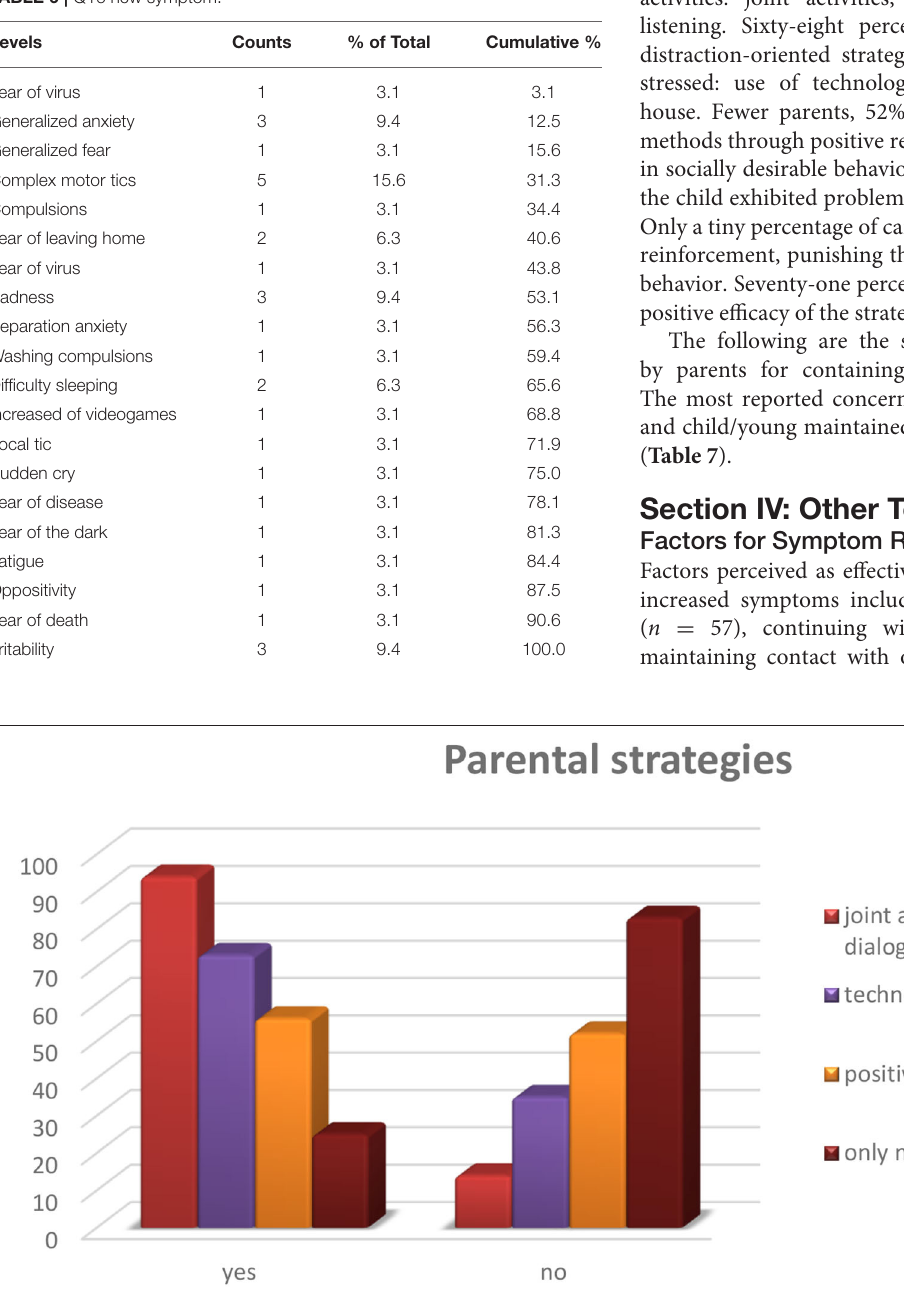
FIGURE 2 | Q.17: What do you do to contain your child’s discomfort?